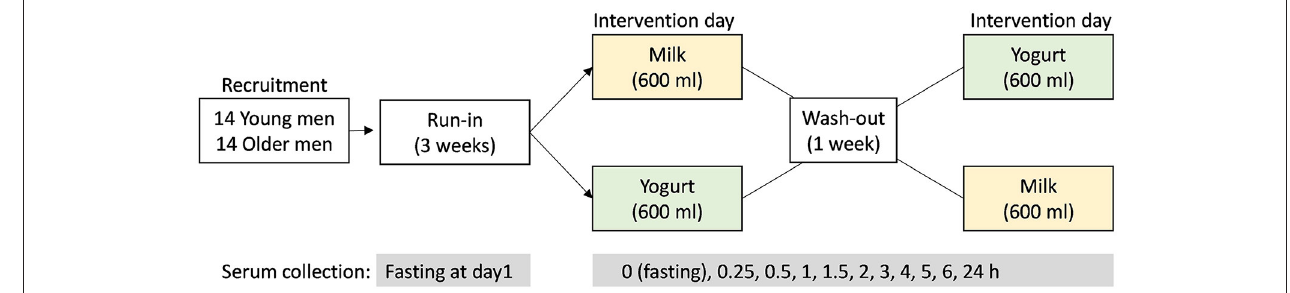
FIGURE 1 | Study design of the randomized, controlled, crossover study. After the 3-week run-in period, the test products (milk or yogurt) were administrated in a randomized order. Serum samples were collected before (0h) and up to 6h after dairy product intake according to the defined intervals.